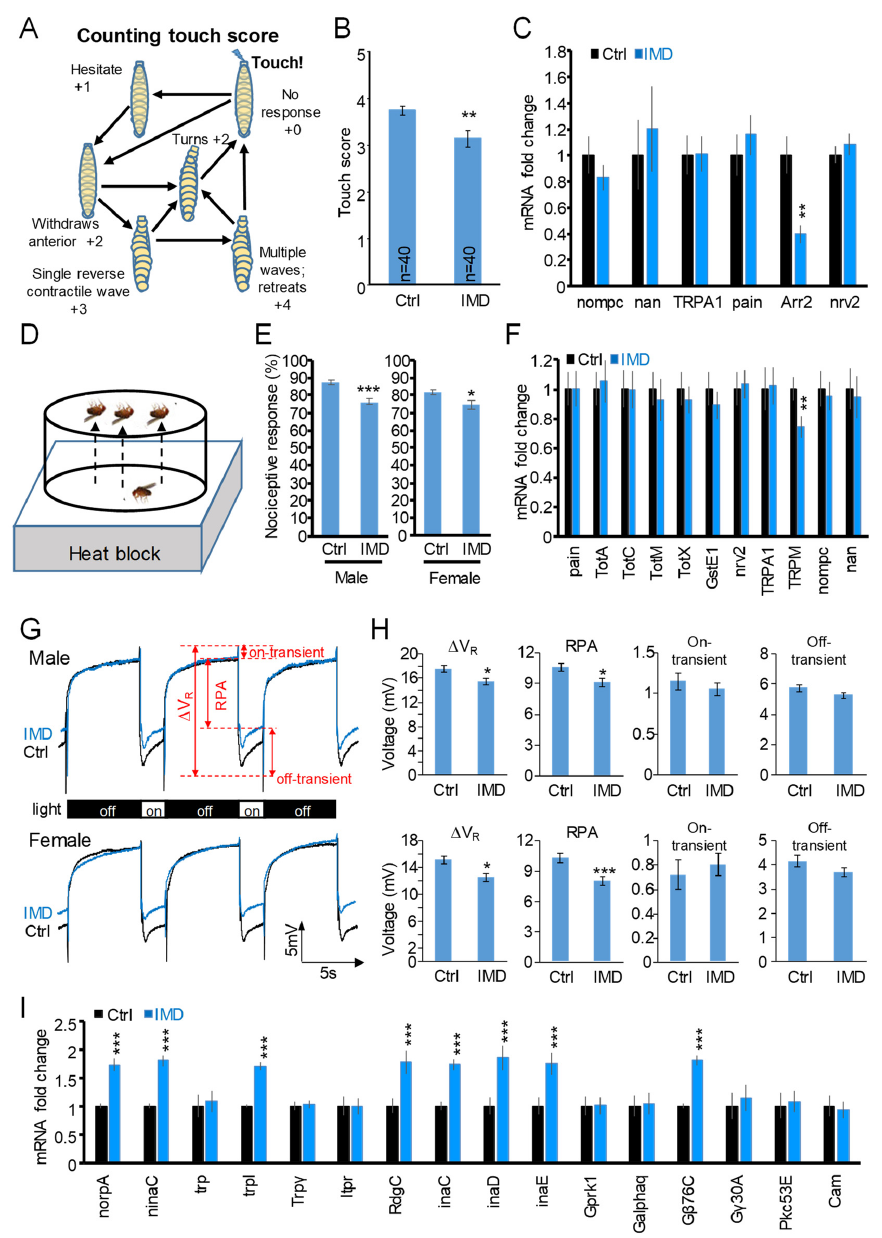
Figure 3. Chronic IMD treatment evoked behavioral phenotypes of the fruit fly. IMD caused alteration of the mechanosensory response: ( A ) scheme showing touch score counting; ( B ) the touch score; ( C ) gene expression of the mechanosensory pathway; IMD decreased the nociceptive response; ( D ) diagram showing the nociception assay; ( E ) the nociception behavior of male and female flies; ( F ) gene expression of the nociception pathway; IMD causes alteration of the light perception; ( G ) the representative waveform of electroretinogram (ERG) upon light on-off stimuli; ( H ) the quantifica- tion of ERG waveform; ( I ) gene expression of the phototransduction pathway. Error bar stands for standard error of the mean. The *, **, or *** denotes the p -value < 0.05, 0.01, or 0.001 for Student’s t -